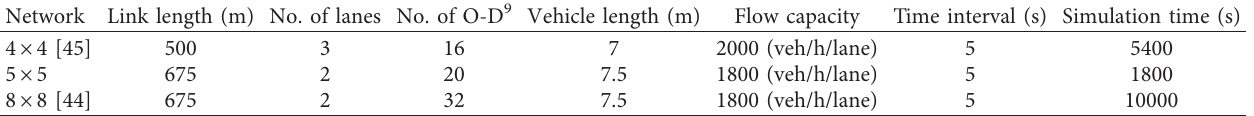
Table 2: The properties of